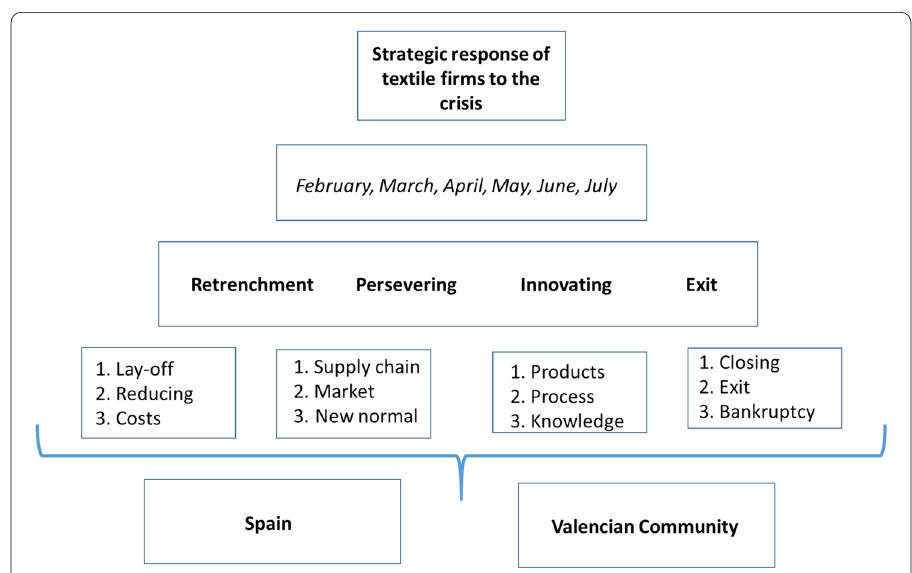
Fig. 2 Umbrella research design. The cascade structure goes from more general (strategic response) to more specific (subcodes). The latest level indicates that the codes differentiated the spatial origin of the